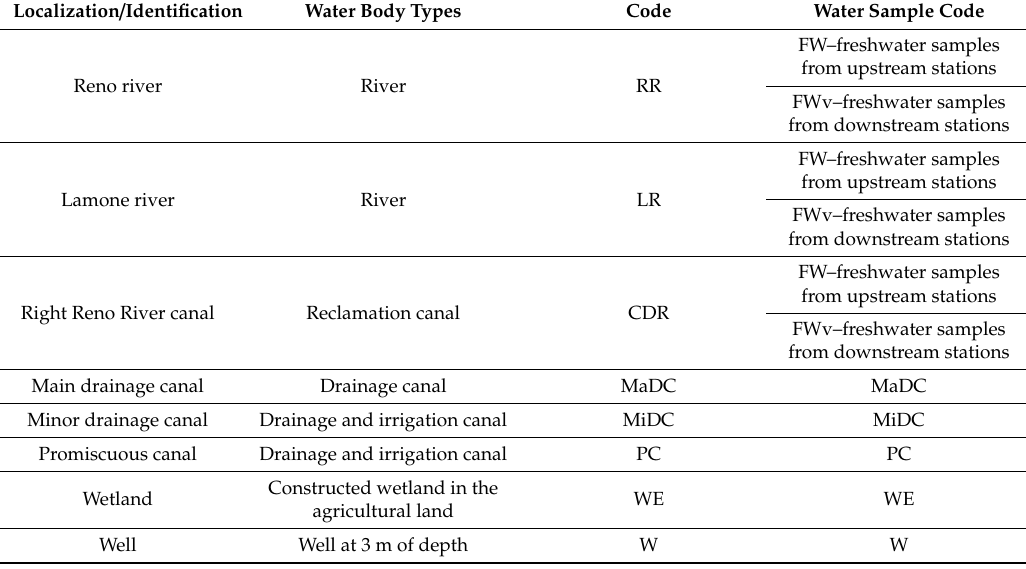
Table 1. Brief description and codes of sampled water